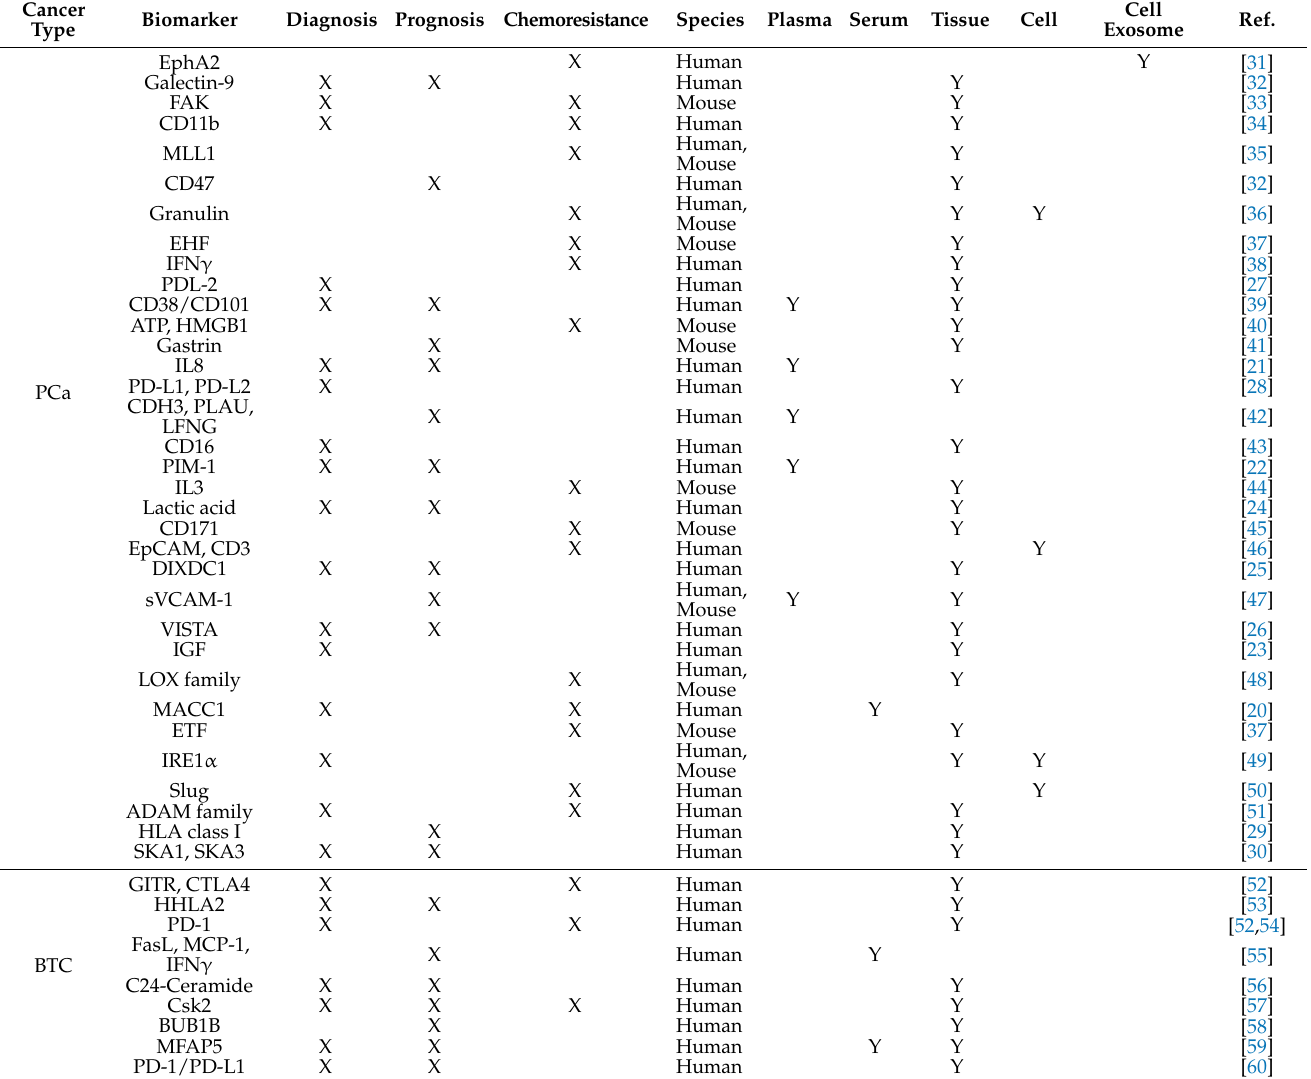
healthy subjects [28]. Low HLA class I expression in PCa tissues was the only risk factor for poor survival; PD-L1-negative and HLA class I high-expressing PCa was significantly associated with an increased number of infiltrating CD8+ T cells in the TME, and with improved prognosis [29]. The spindle and kinetochore-associated genes SKA1-3 were highly expressed in PCa tissues; high expression of SKA1 and SKA3 was associated with a poor prognosis [30]. Table 2. Biomarker candidates for proteins identified in the present systematic review. Cancer Type